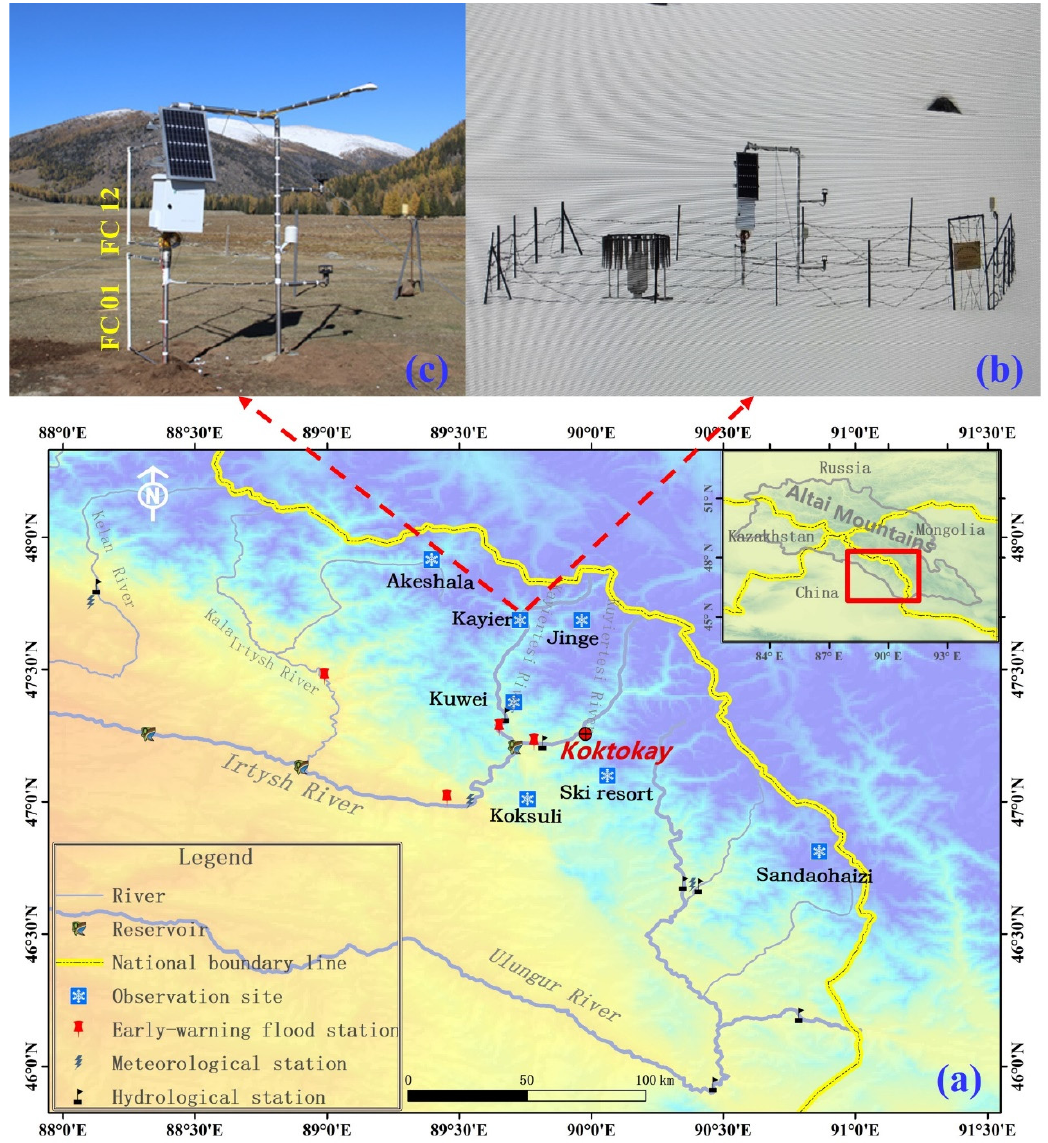
Figure 1. Maps showing the locations of observation sites operated by Koktokay snow station ( a ), the FlowCapt sensor with the Automatic Weather Station under snow-covered ( b ) and snow-free ( c ) conditions.